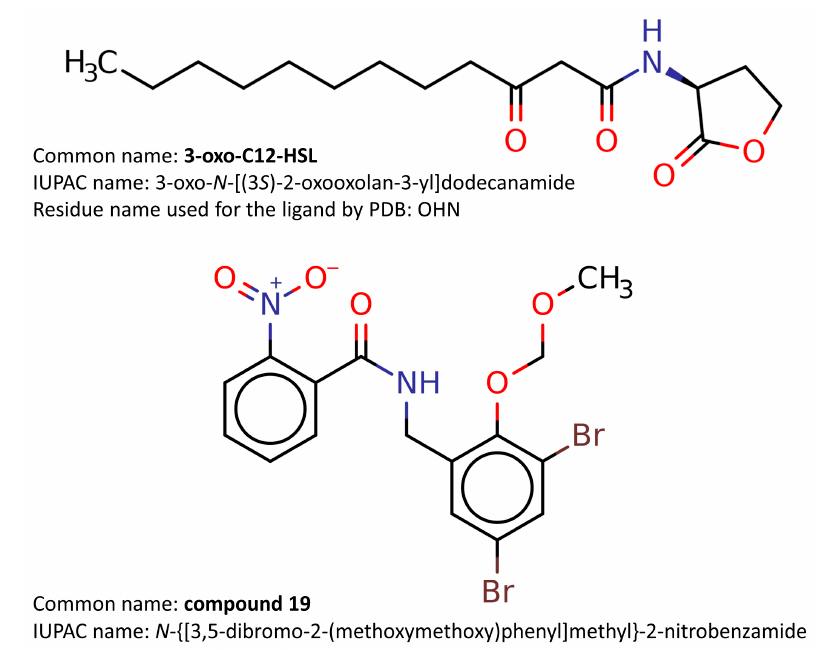
Figure 5. Molecular structures of the bona fide LasR ligands 3-oxo-C12-HSL (native autoinducer) and compound 19 (non-native agonist).